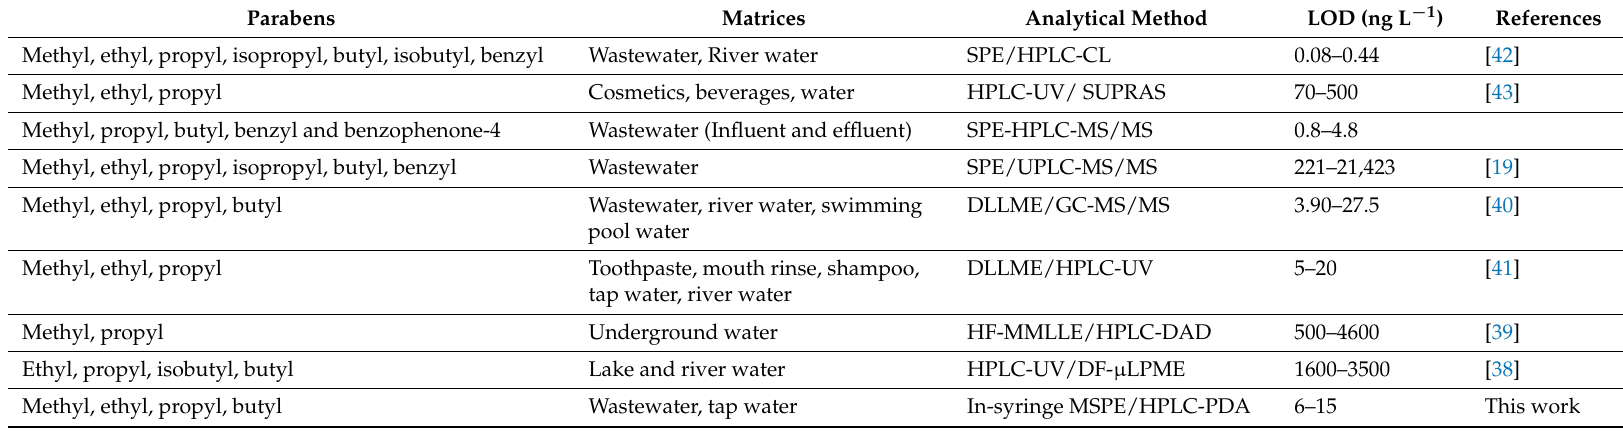
Table 5. Comparison of the proposed microextraction method with literature for determination of